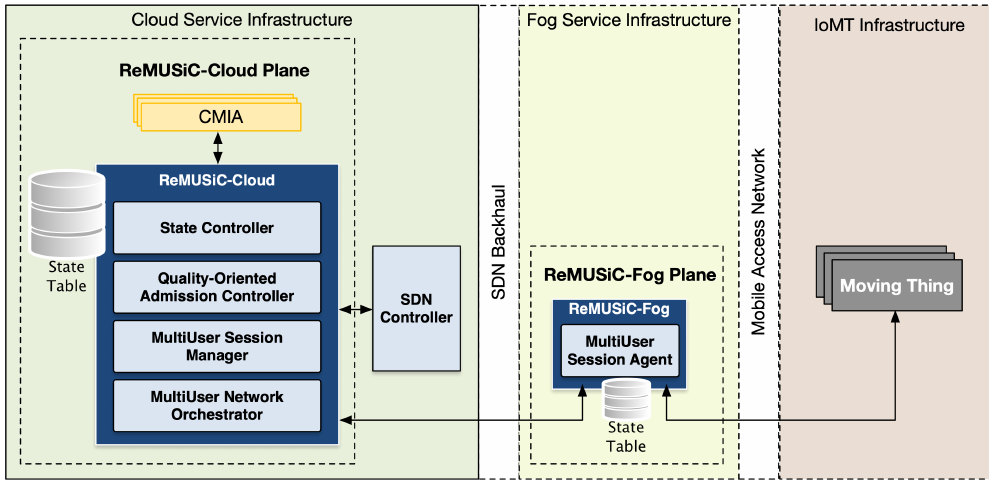
Figure 2. ReMUSiC’s internal architecture in the Internet of Moving Things (IoMT)